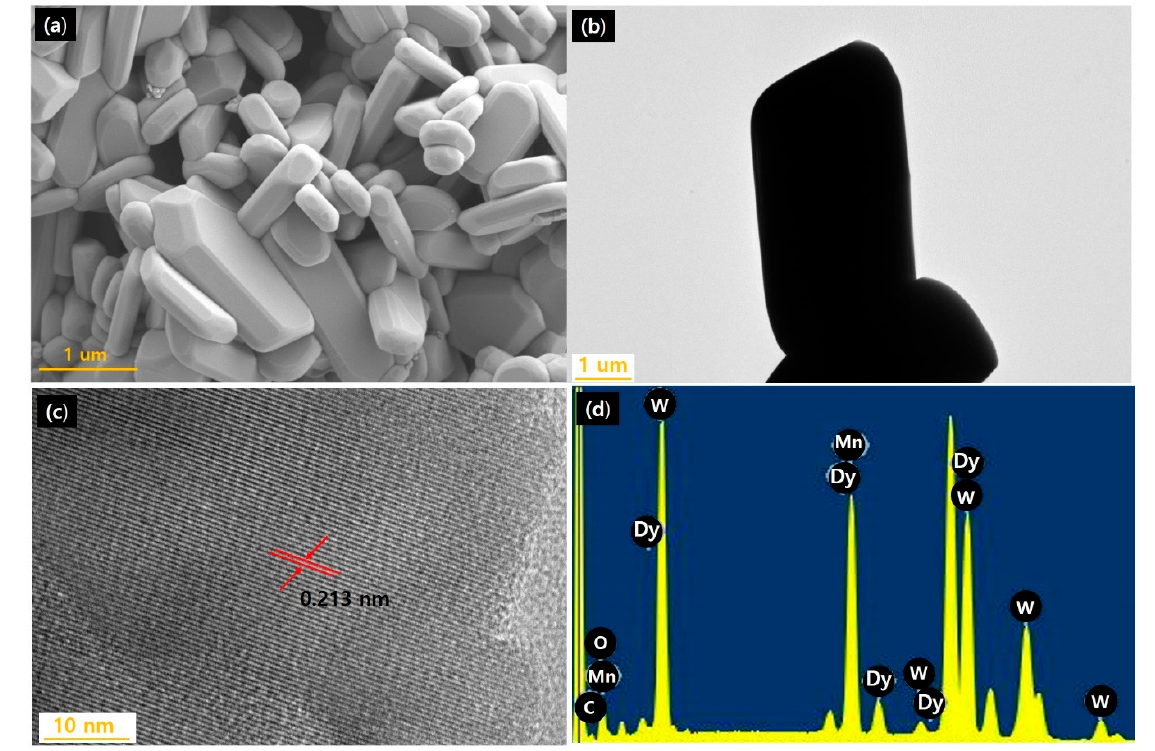
Figure 7. ( a ) SEM image of MnWO 4 :Dy 3+ , ( b ) TEM image of MnWO 4 :Dy 3+ , ( c ) high-resolution image, and ( d ) EDX composition analysis result.